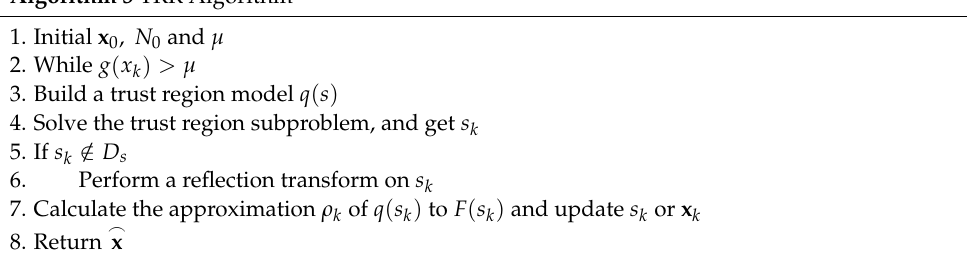
Algorithm 3 TRR Algorithm